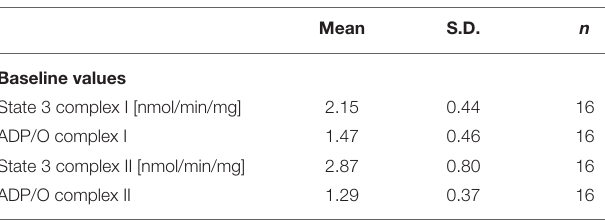
TABLE 1 | Baseline values.